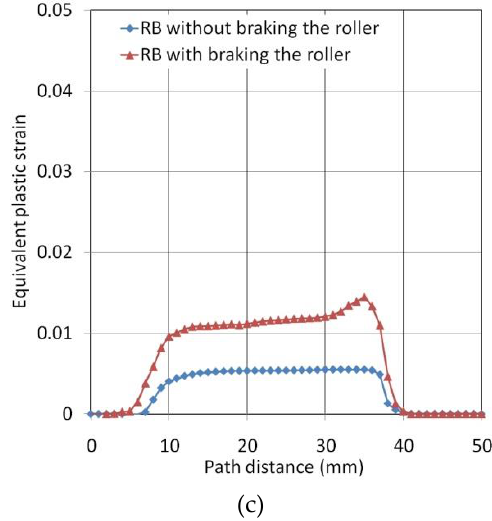
Figure 21. Distribution of the equivalent plastic strains along paths located at a depth of ( a ) 0.6 mm, ( b ) 1.2 mm and ( c ) 1.8 mm.